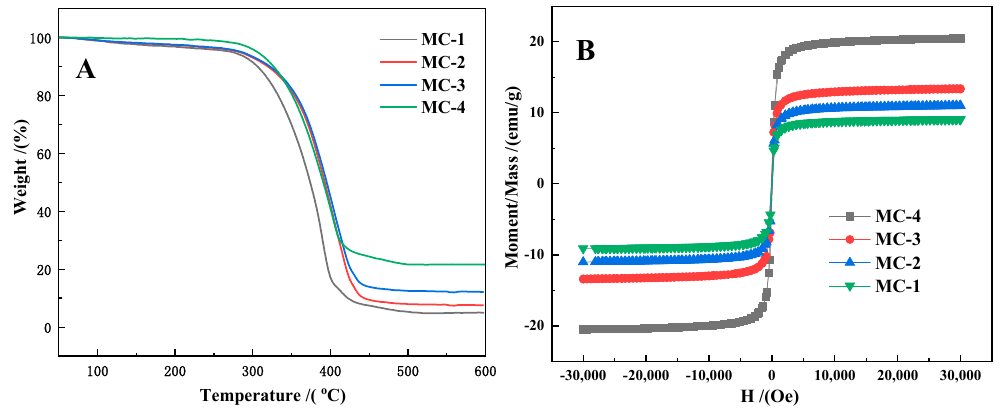
Figure 7. TGA curve ( A ) and VSM ( B ) curve of C/Fe 3 O 4 composite microspheres.